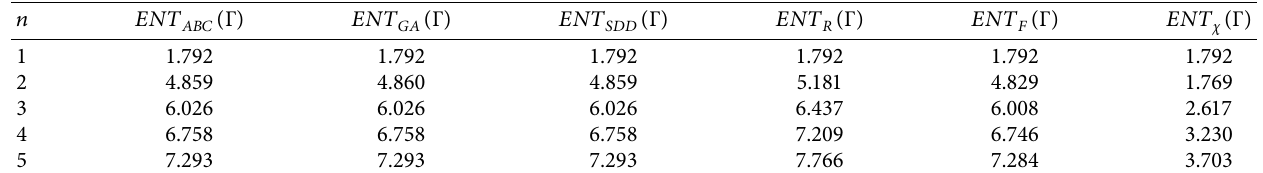
Table 5: Numerical comparison for Theorem